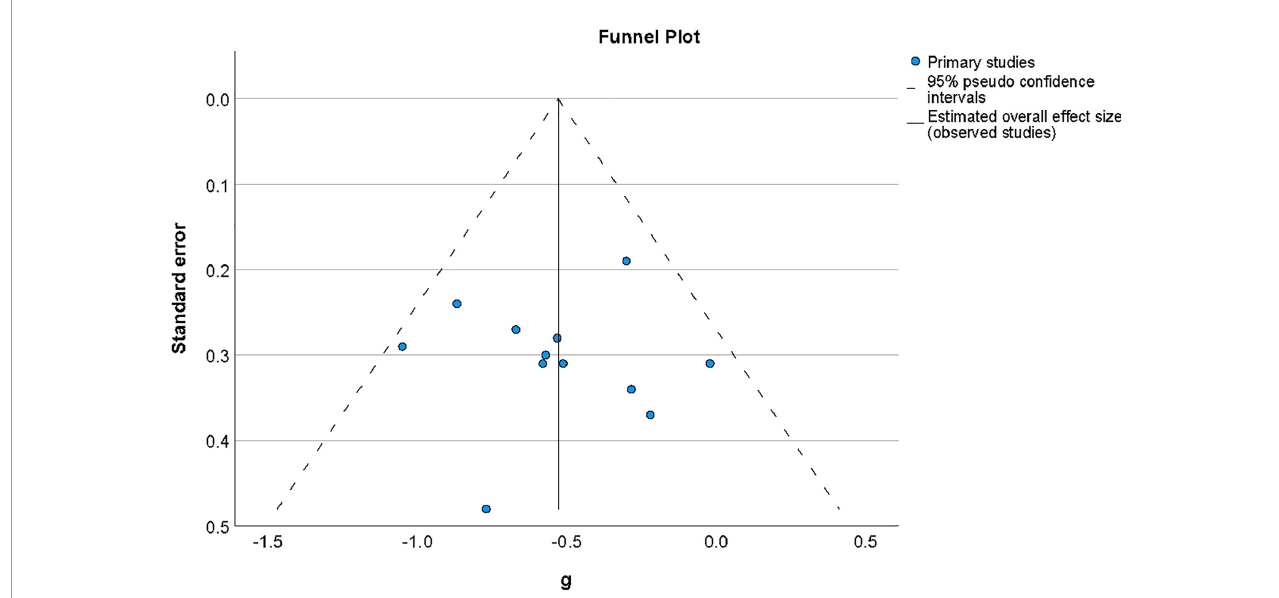
FIGURE4 Funnel plot of the distribution of effect sizes by their standard error for studies of metacognition in the presence of psychosis-related symptoms. The vertical line indicates the value of the summary effect size. The area of the graph within the triangle represents the values which samples have 95% probability of showing if variance is homogeneous.